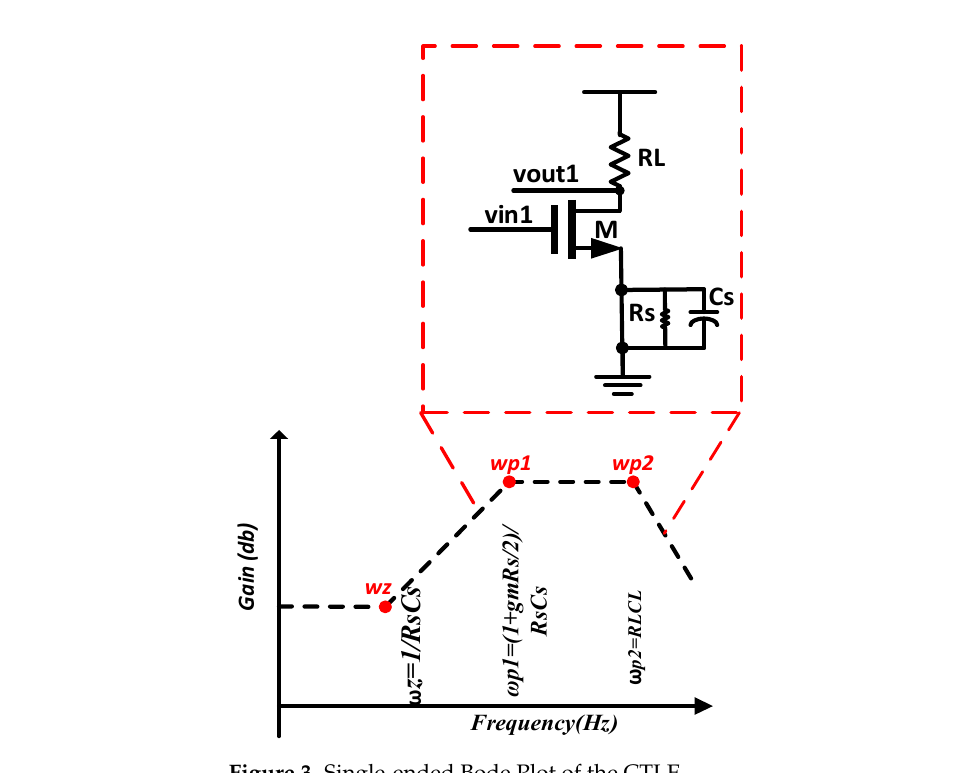
Figure 3. Single-ended Bode Plot of the CTLE.